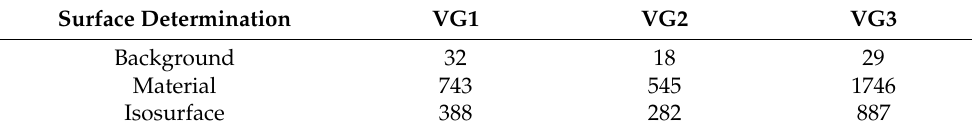
Table 1. Values for surface determination in Hounsfield units (HU).